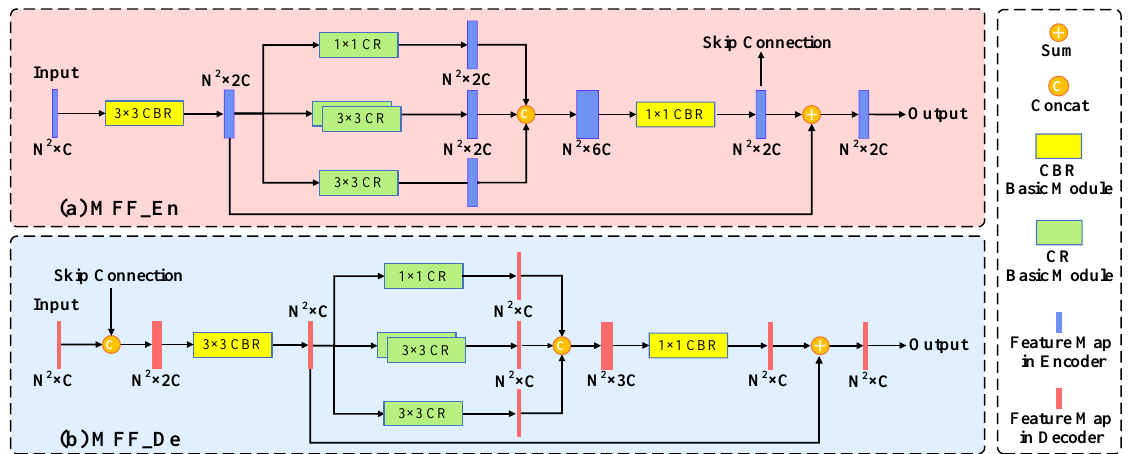
Figure 3. The details of MFF_En and MFF_De. ( a ) The structure of MFF_En. ( b ) The structure of MFF_De. In the graph, N 2 represents the size of the feature map, while C represents the number of the feature map